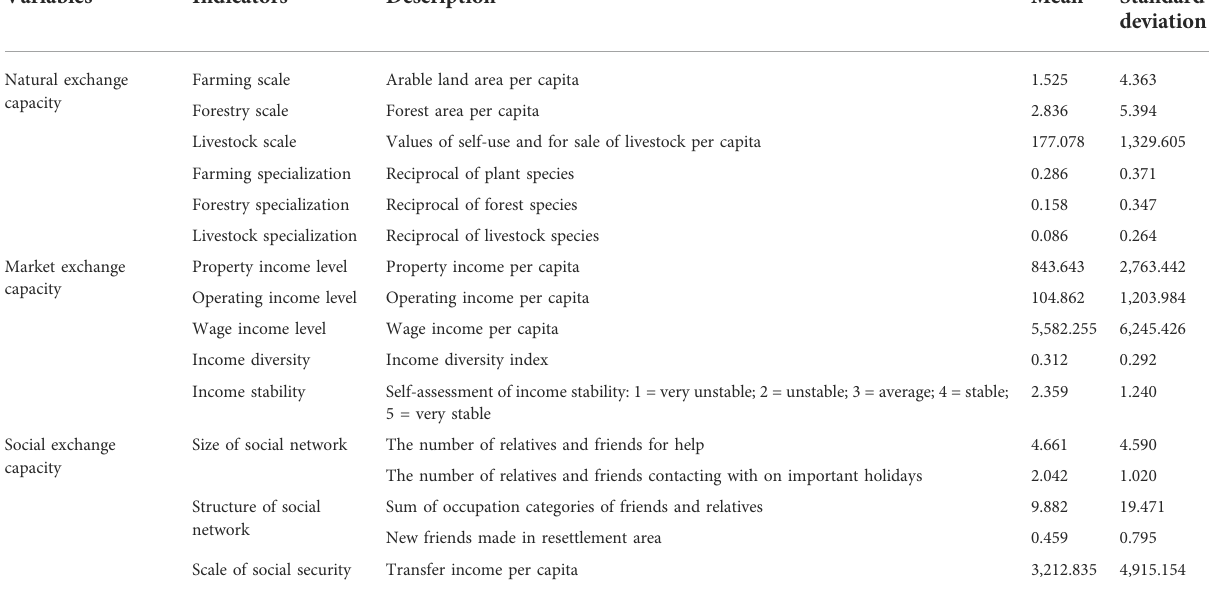
TABLE 1 Variable design and statistics for livelihood exchange capacities.